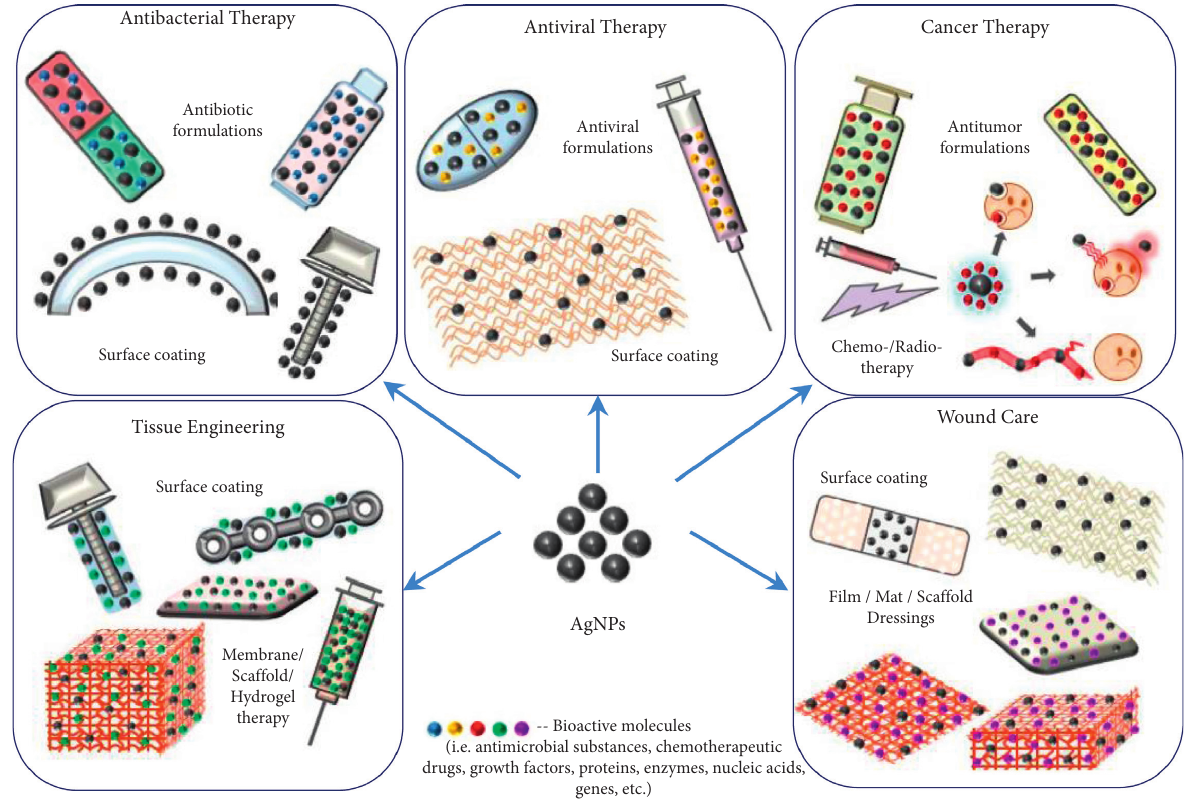
Figure 1: Applications of silver nanoparticles in biomedicine reproduced from [2] under the terms of the creative commons CC BY